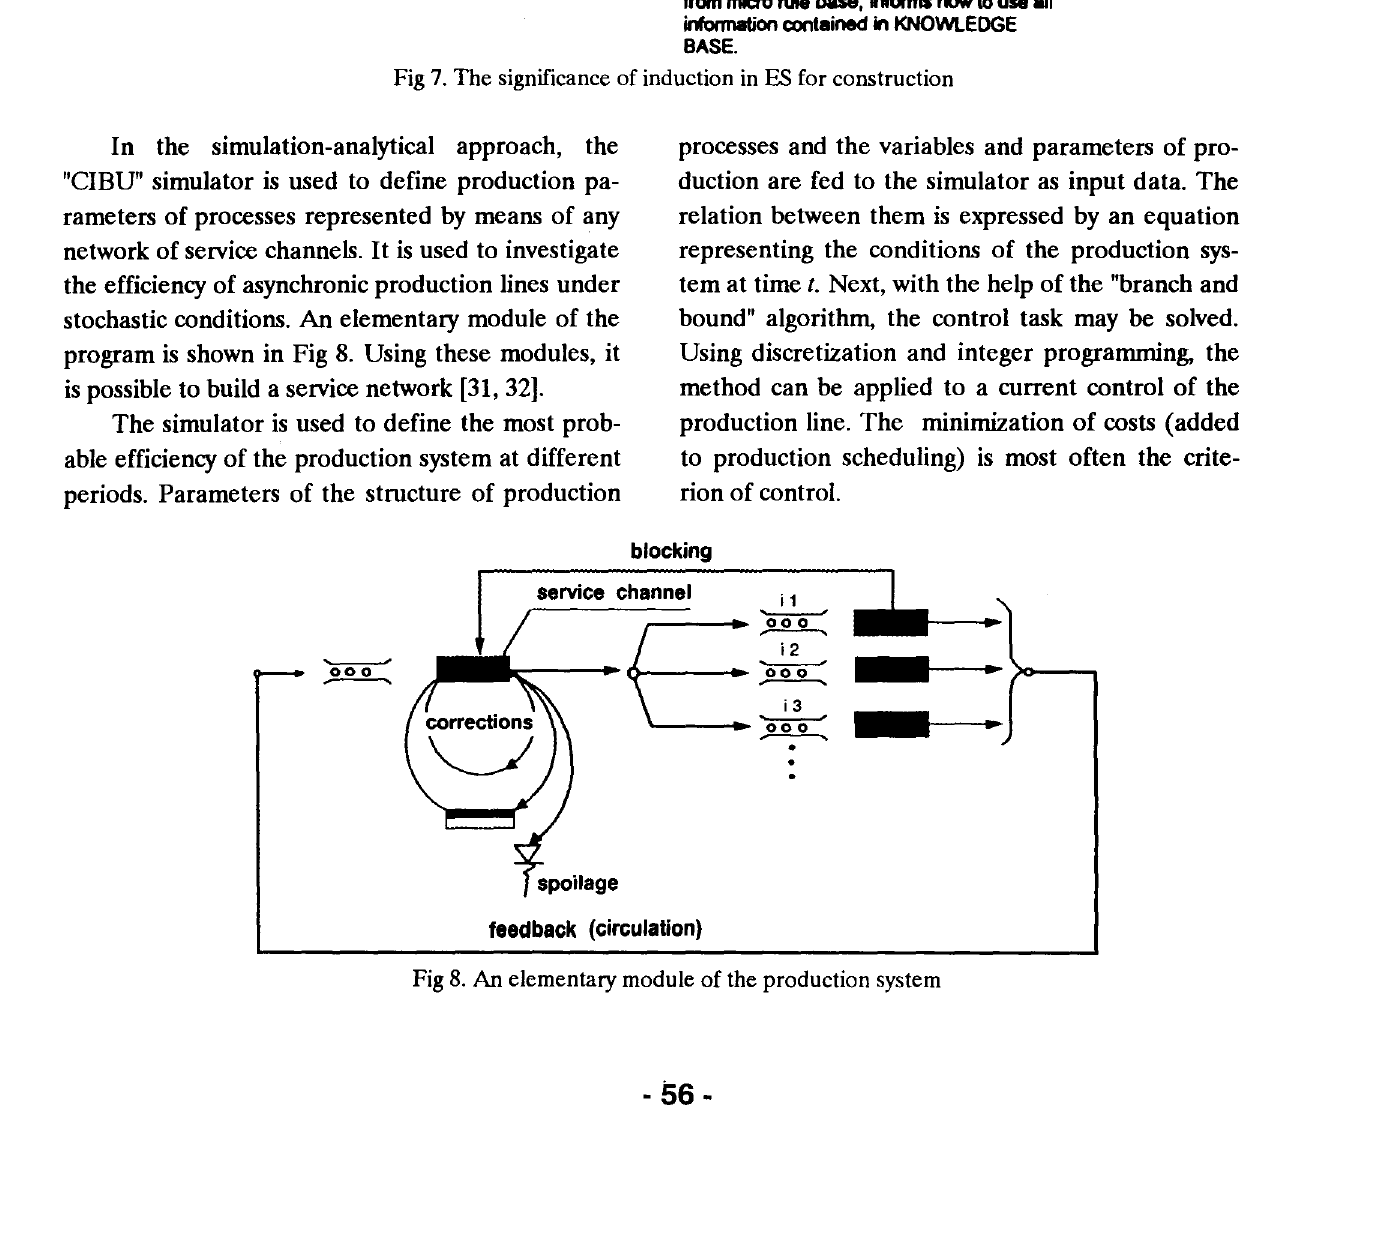
Fig 7. The significance of induction in ES for construction